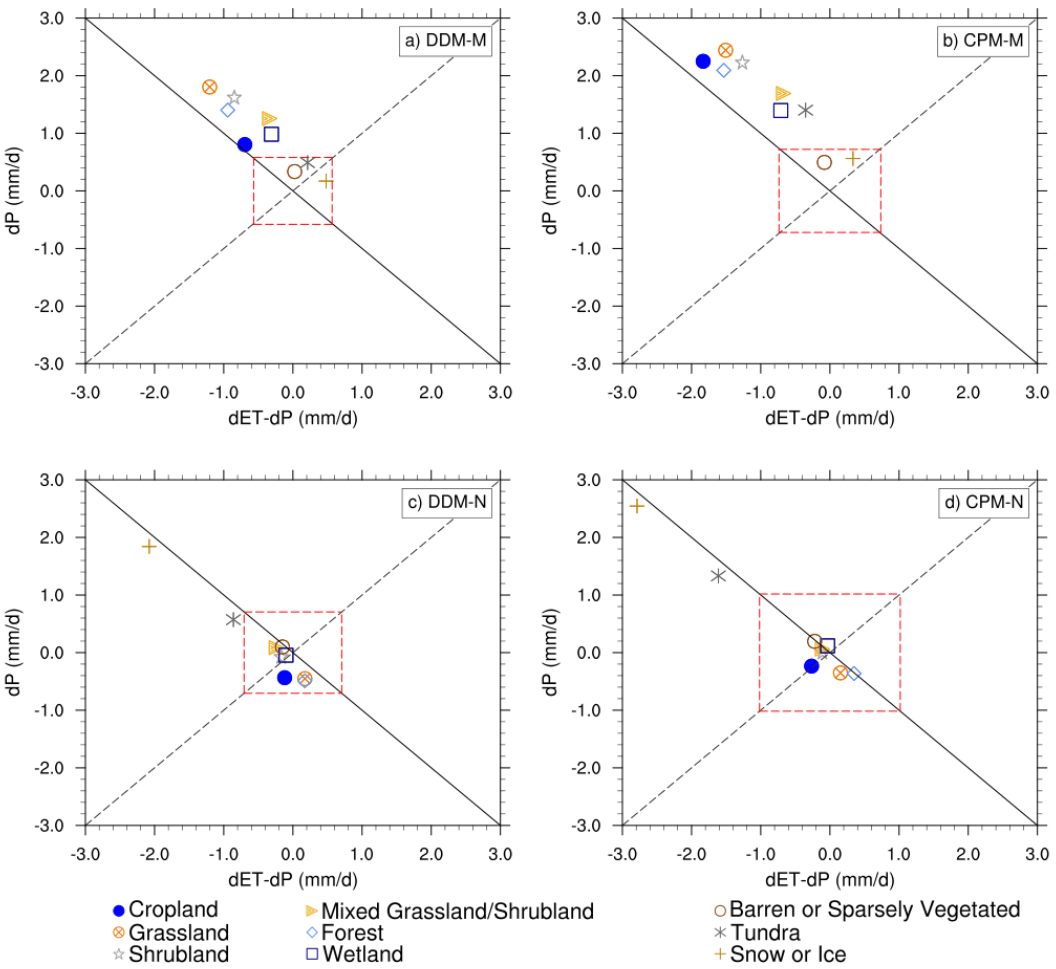
Figure 8. Deviations (monsoon: ERA-Interim minus DDM or CPM; non-monsoon: DDM or CPM minus ERA-Interim) in ET (units: mm/d) from precipitation and other factors for each land-use category in the ( a , b ) monsoon and ( c , d ) non-monsoon seasons. The ordinate is the ET deviation from precipitation, the abscissa is the ET deviation from the other effects. The black solid line indicates 1:1 correspondence of the first and third quadrants, and the gray dashed line indicates 1:1 correspondence of the second and fourth quadrants. The red dashed box indicates the SD from precipitation and other effects.